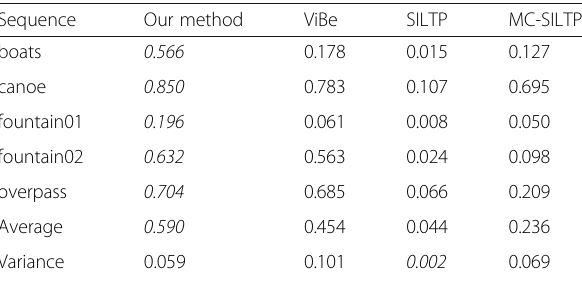
Table 3 F1 results on the ChangeDetection.net dataset dynamic background image sequences